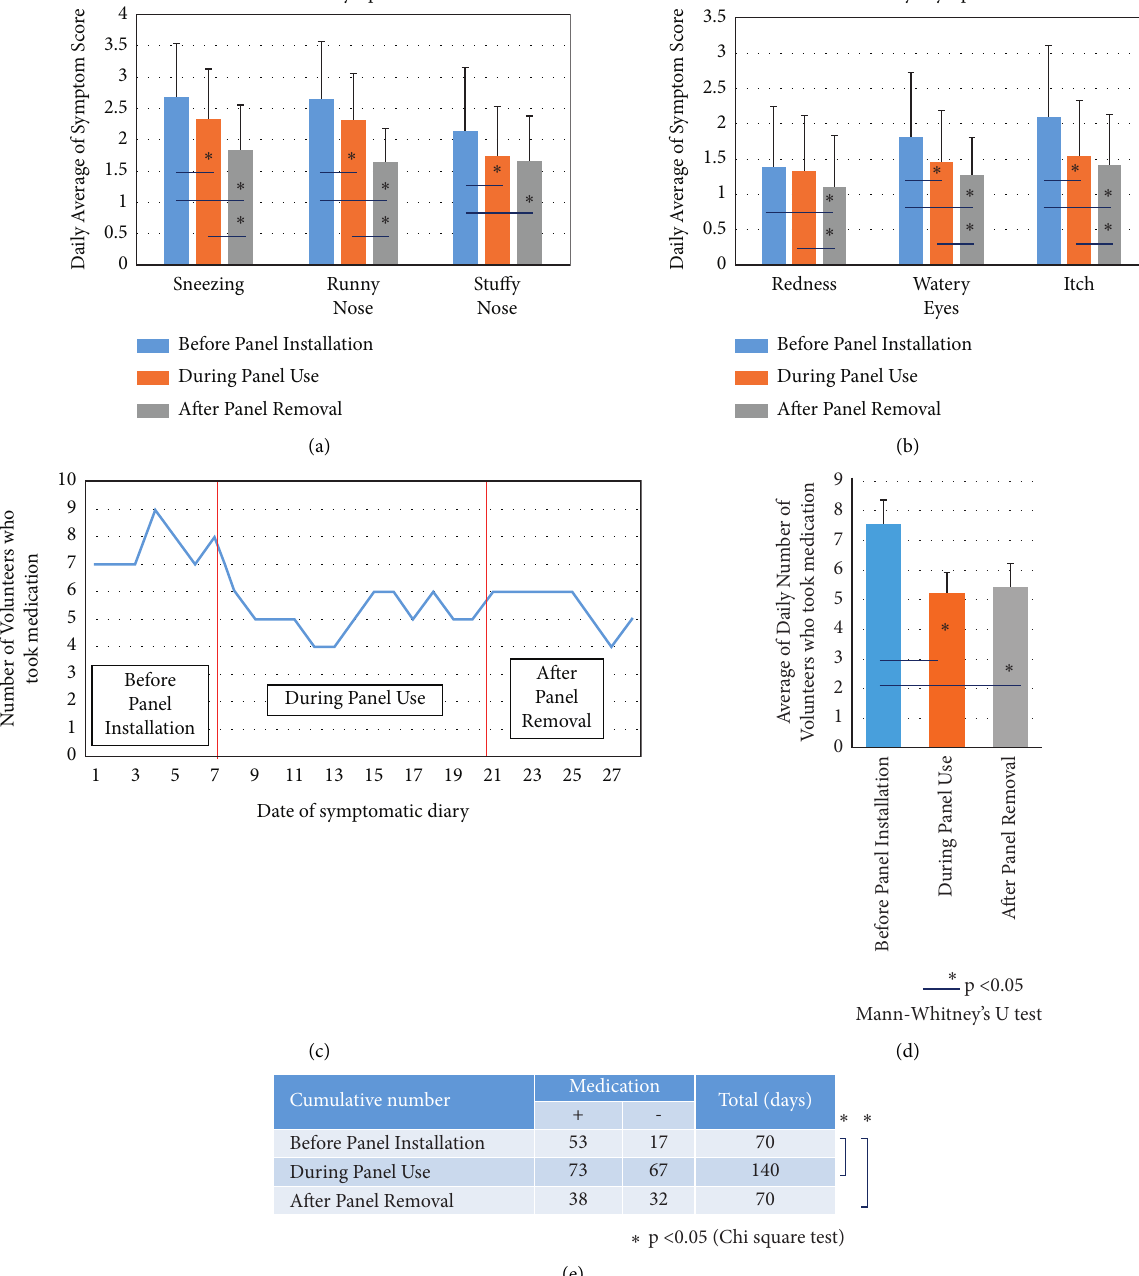
Figure 3: Analyses of symptoms from the “Symptom Diary.” (a) Comparison of nose symptoms such as sneezing, runny nose, and stuffy nose for the periods “before panel installation,” “during panel use,” and “after panel removal.” Scores were extracted from each “Symptom Diary” and the daily score average of the 10 subjects was plotted. (b) Comparison of eye symptoms such as redness, watery eyes, and itch during the periods “before panel installation,” “during panel use,” and “after panel removal.” Scores were extracted from each “Symptom Diary” and the daily score average of the 10 subjects was plotted. (c) Data pertaining to the use of medication as recorded in the “Symptom Diary” for each subject were plotted. (d) The average (with SD) daily number of volunteers who took medication in three periods “before panel installation,” “during panel use,” and “after panel removal” were plotted. In panels (a), (b), and (d), differences were initially examined by one-way ANOVA analysis, and then after confirmation of significance, a Mann–Whitney U test was performed to analyze the differences between the two groups. The ∗ indicates statistical significance, P < 0 . 05. (e) During the three periods “before panel installation,” “during panel use,” and “after panel removal,” the number of volunteers who took medication and the number of days were multiplied (med- ication +row), and the days and number of volunteers who did not take medication were also multiplied (medication–row). Differences between individual periods were then examined by a chi-squared test. The ∗ indicates significance, P < 0 .